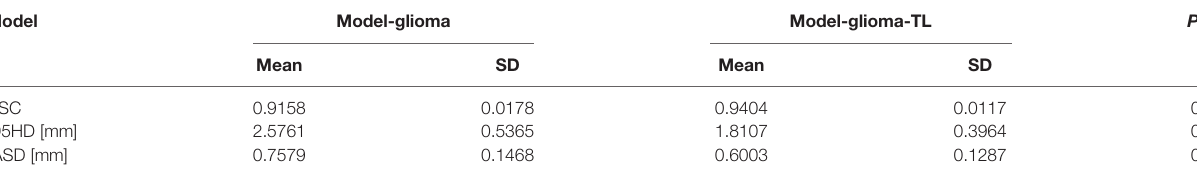
TABLE 2 | Results for autosegmentation of the GTVs of glioblastomas.